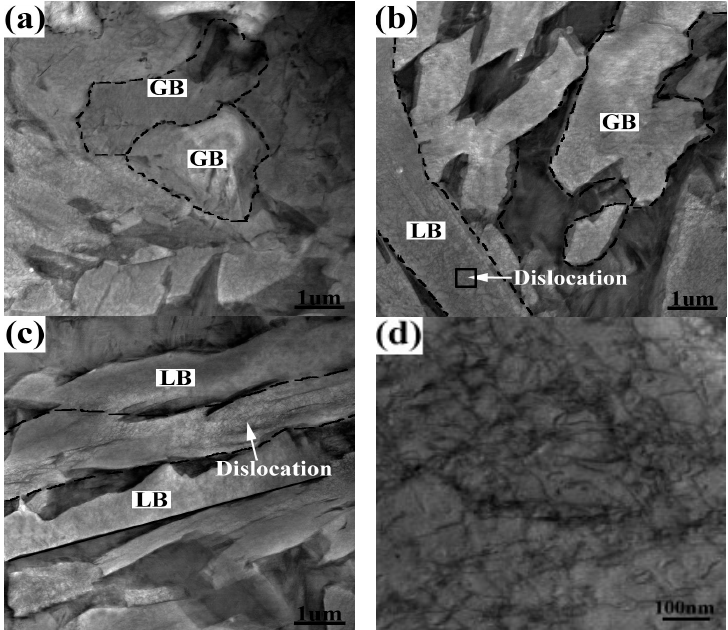
Figure 3. TEM micrographs showing the morphology of bainite and dislocation: ( a ) steel #1, Mo ‐ free; ( b ) steel #2, 0.134 wt. % Mo; ( c ) steel #3, 0.273 wt. % Mo; ( d ) micrograph in high magnification of the square zone in ( b ).